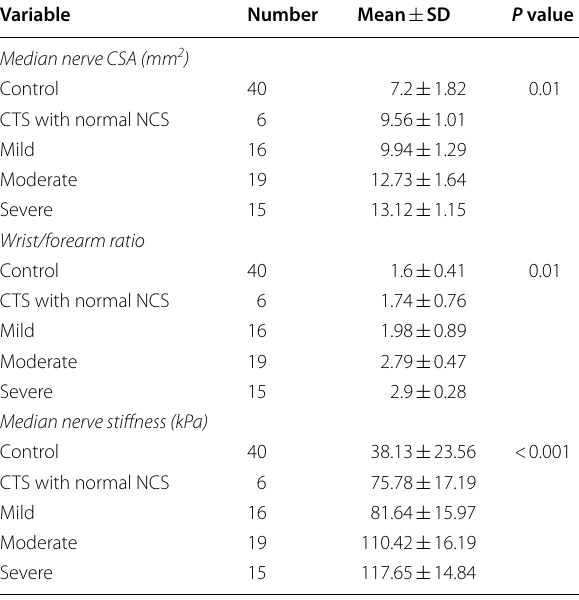
characteristic curve analy- sis revealed that the optimal cutoff values for median the mean stiffness value of the median nerve was